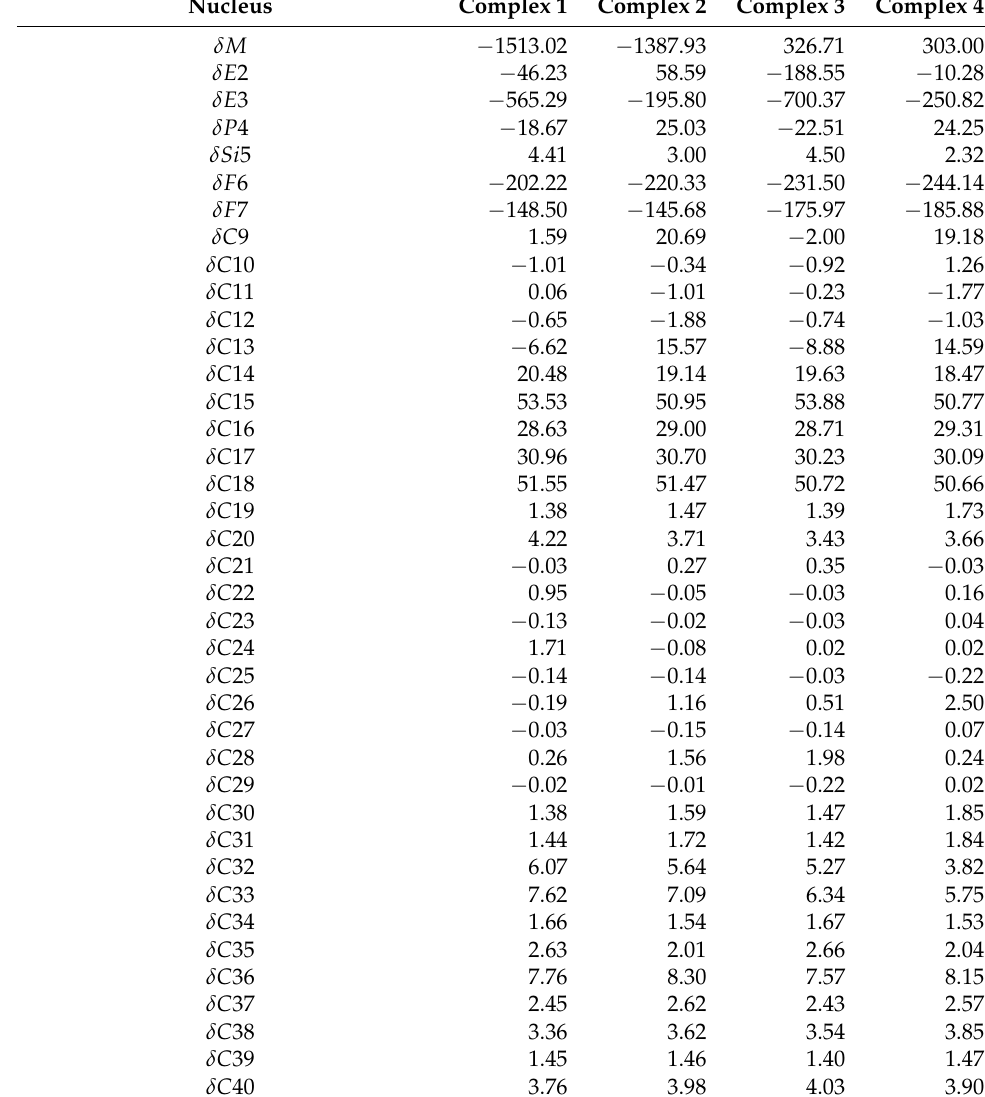
Table 2. Chemical shifts ( M = 113 Cd or 199 Hg and E = 77 Se or 125 Te), δ (ppm) calculated using the two-component ZORA approach with the PBE0 exchange-correlation functional and the TZ2P basis